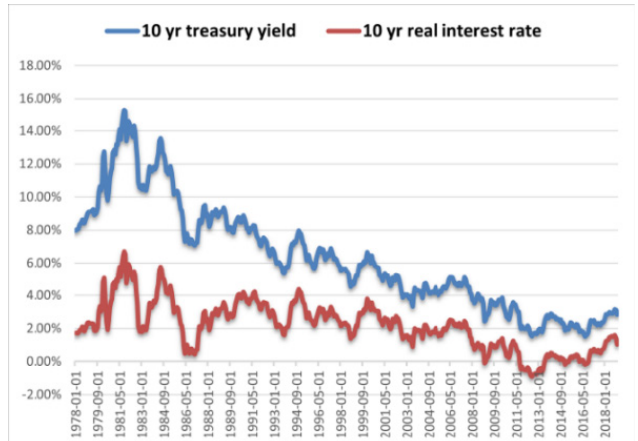
Figure 5. Changes in long-term real and nominal interest rates (1978–2018) .